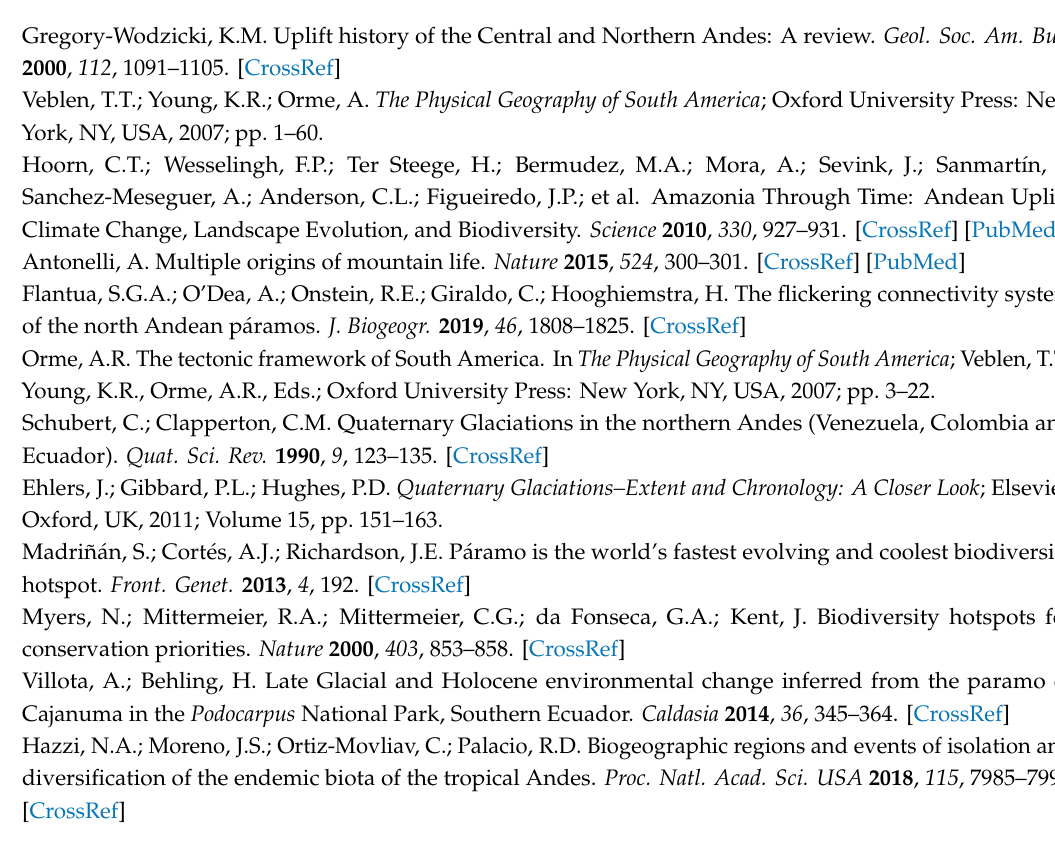
Figure S1: Male morphological characters for clades 1 and 5, showing high morphological variation; Figure S2: Male morphological characters for clades 1 and 5, showing high morphological variation Figure S3: Single locus and multilocus species delimitation analyses for Panabachia